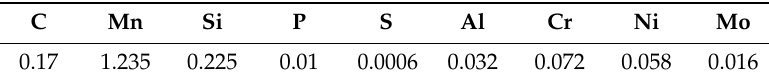
Table 1. Chemical composition (%).